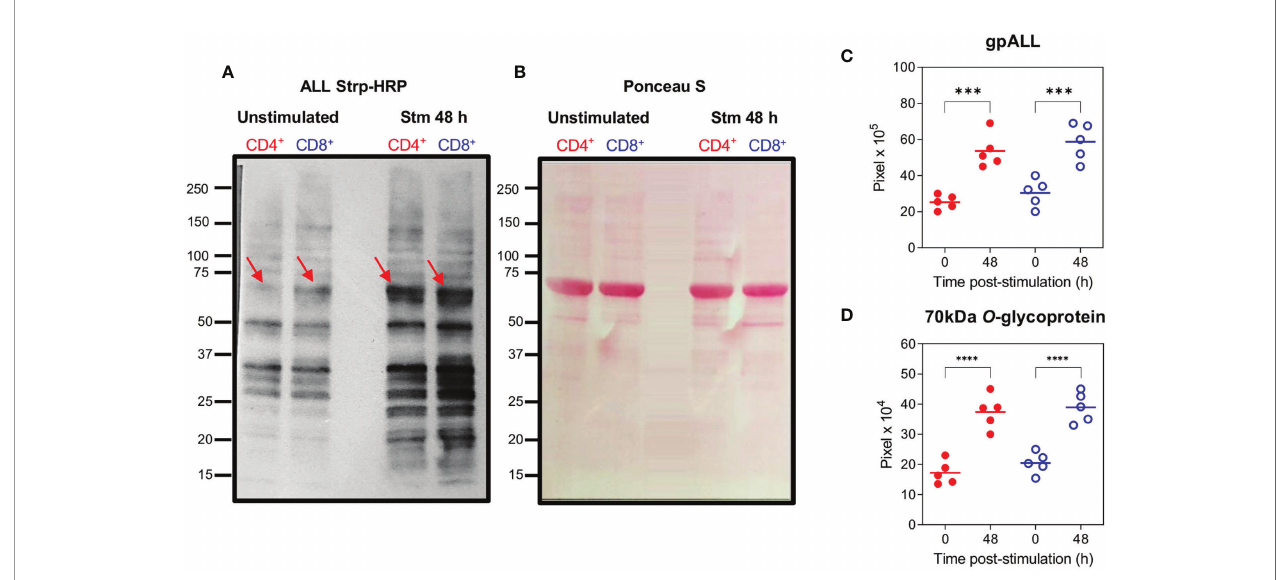
FIGURE 2 | O -glycoproteins detected by ALL are increased on CD4 + and CD8 + T cells after activation. Splenocytes were stimulated with anti-CD3 and anti-CD28 mAbs for 48 h, after harvesting, CD4 + and CD8 + T cells were separated by cell sorting and protein extracts were obtained. Samples were analyzed by lectin blot using ALL Strp-HRP (A) , O -glycoproteins from unstimulated (Lanes 1 and 2) and stimulated (Lanes 3 and 4) from CD4 + (Lanes 1 and 3) and CD8 + (Lanes 2 and 4) cells are shown; the red arrow indicates the previously reported 70-kDa O -glycoprotein recognized by ALL; the protein pro fi le transferred to a PVDF membrane and stained with Ponceau S is included as a loading control (B) . Quanti fi cation of the accumulative intensity from the total number of bands per lane (C) and the 70-kDa band recognized by ALL (D) from 5 independent experiments pooling the cells from 2 animals per group. Data were analyzed using ANOVA followed by Bonferroni ’ s multiple comparison test between unstimulated and stimulated (CD4 + (Red full circles) and CD8 + (Blue open circles); ***p < 0.001, ****p <